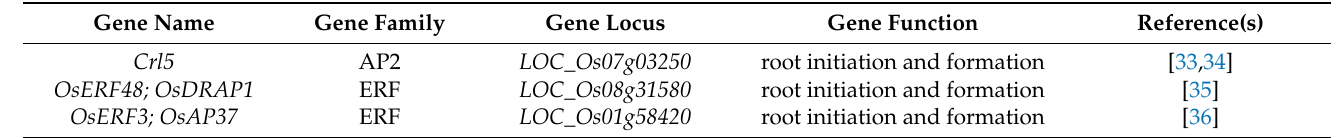
Table 6. Genes associated with root development in